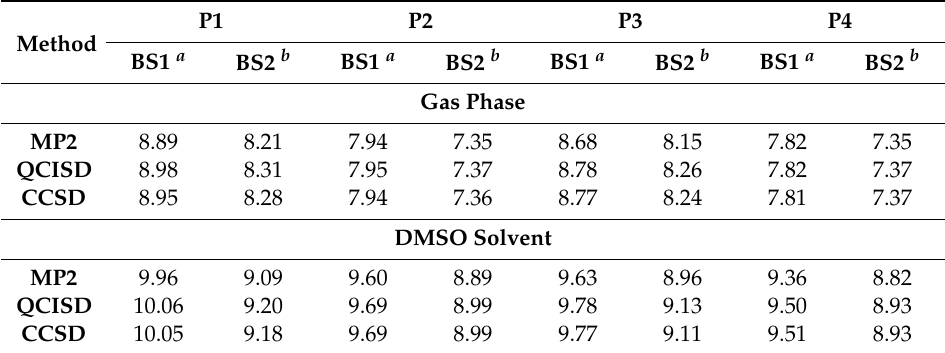
Table 1. HOMO-LUMO ( E HL ) energy gap (in eV) for the investigated systems in gas phase and DMSO